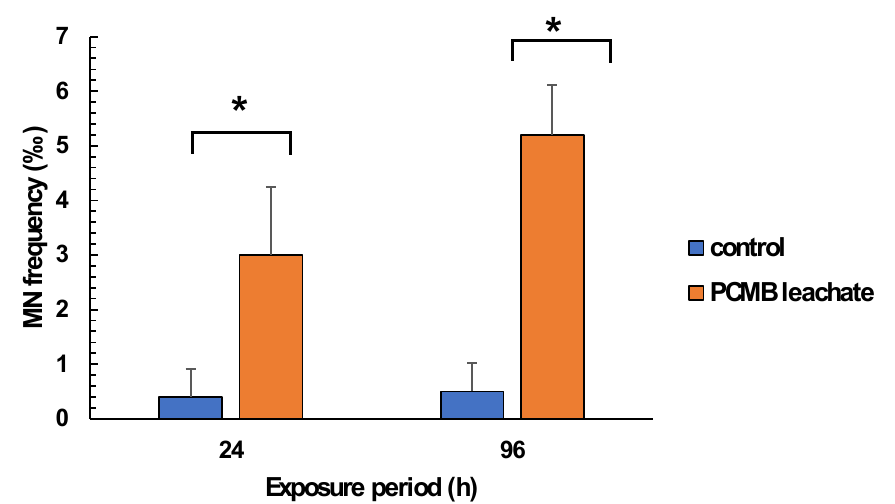
Figure 4. Determination of ( A ) superoxide anions ( . O 2 − ), ( B ) nitric oxides (in terms of NO 2 − ), and ( C ) lipid peroxidation (in terms of MDA equivalents) in hemocytes/hemolymph of mussels exposed to PCMB-ASW for 96 h. The results (expressed as OD 620 nm mg protein − 1 , μ mol NO mg protein − 1 , and nmol MDA mg protein − 1 , respectively) are mean ± SD from 3 different measurements (each measurement was performed in duplicate) in all cases. Asterisks (*) indicate significant difference from the respective control. Values that share the same letter differ from each other (Mann–Whitney u-test, p < 0.05).